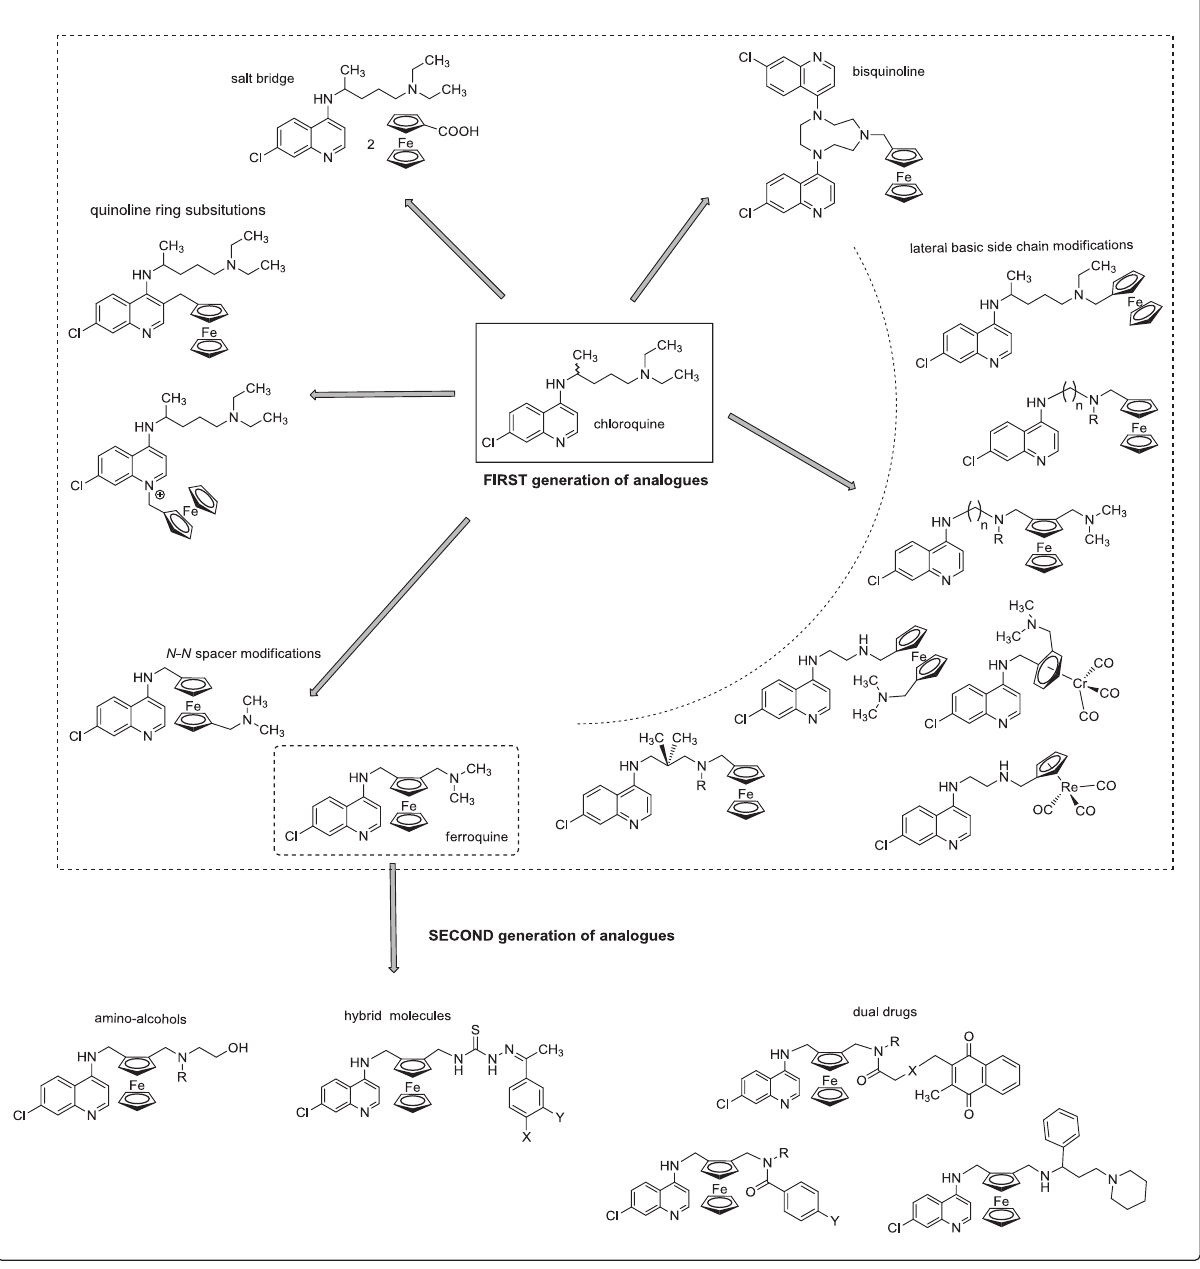
Fig 1. – Scheme of different strategies adopted in synthesis of ferrocene-CQ